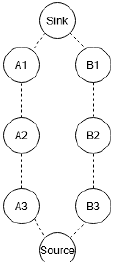
Figure 8. Nodes with corresponding path and hop